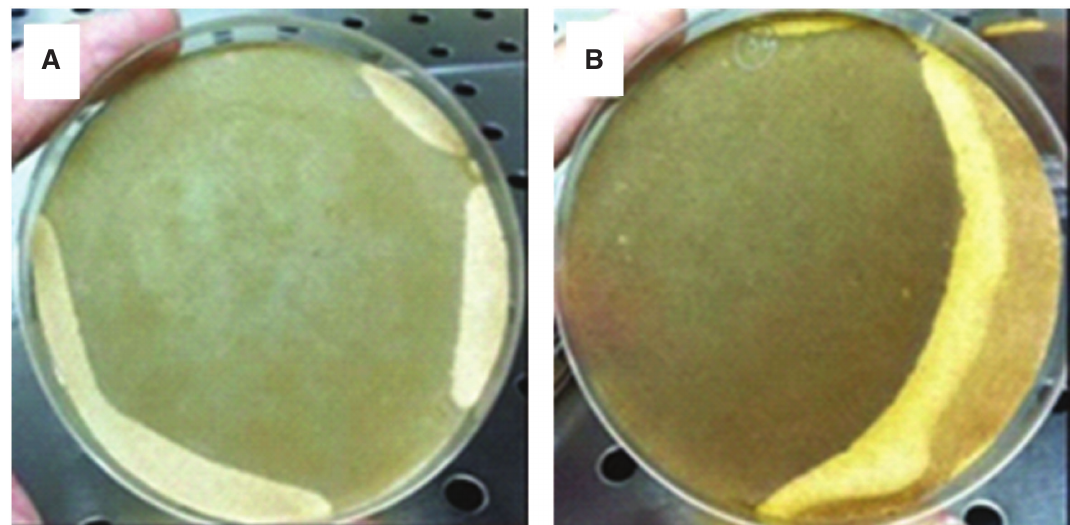
Figure 5: Escherichia coli bacteria grown on the control samples: (A) uncoated cellulose, (B) cellulose immerged for 60 min in a yellow colored solution containing AgNPs.